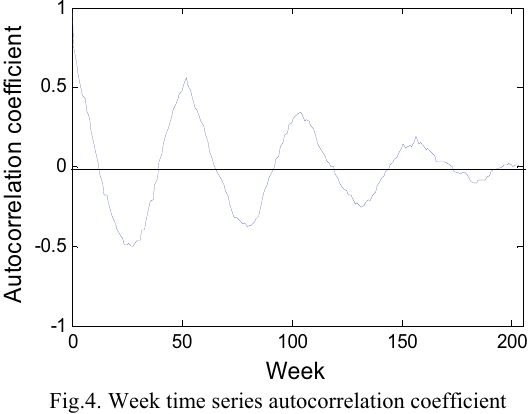
Fig.4. Week time series autocorrelation coefficient Base on the best time delay, set For each m (cid:712) compute and get a series of values about ln ,ln according to G-P algorithm. in Fig.5. The scale-free area in Fig.5 is the correlation dimension. The change curve of correlation dimension with embedded dimension m is shown in Fig.6. It can be seen that with the increase of embedded dimension, when m =9 the correlation dimension reaches saturated. It illustrates that the time series have chaotic nature, and m =9.